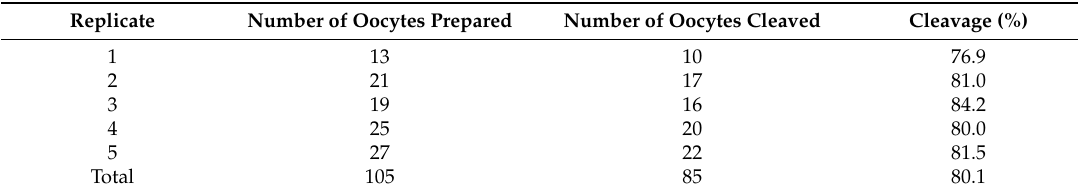
Figure 7. Directions of cellular piercing using the first modified injector. ( A ) Modulate the injection pipette close to the zona pellucida and ensure that vibration of pipette is small, about 6 µ m. ( B ) Touch the zona pellucida. ( C ) Pierce through the zona pellucida. ( D ) Push the tip to the opposite side of the oocytes. ( E ) Pierce through the membrane of the oocytes. ( F ) Apply a gentle positive pressure to prevent the intensive suction of cytoplasm. Scale bars = 15 µ m throughout. Table 1. Set of experimental results on mouse cells with the final parameters for first injector.